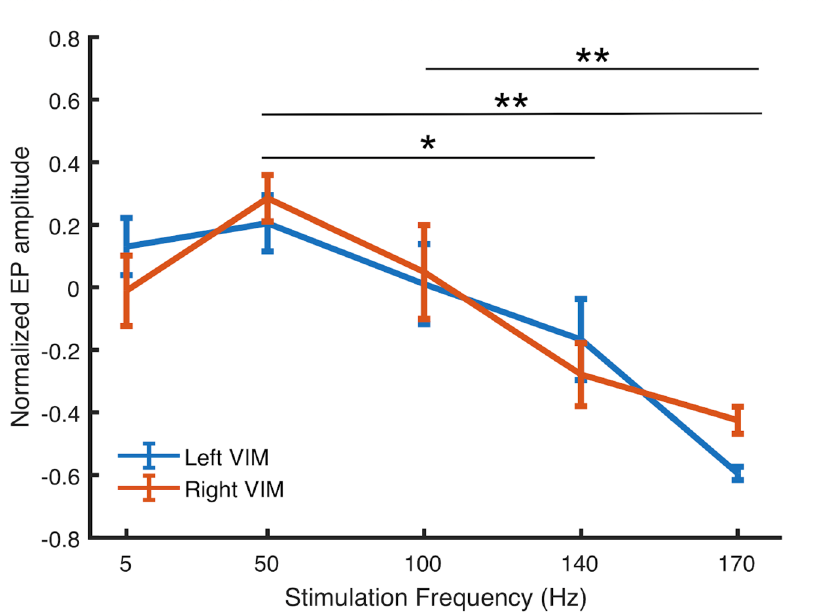
Figure 6. Average EP amplitude as a function of pulse frequency for all subjects. EP amplitude differed significantly between 50 vs. 140 Hz ( p < 0.01), 50 vs. 170 Hz ( p < 0.001), and 100 vs. 170 Hz ( p < 0.001). Error bars indicate standard